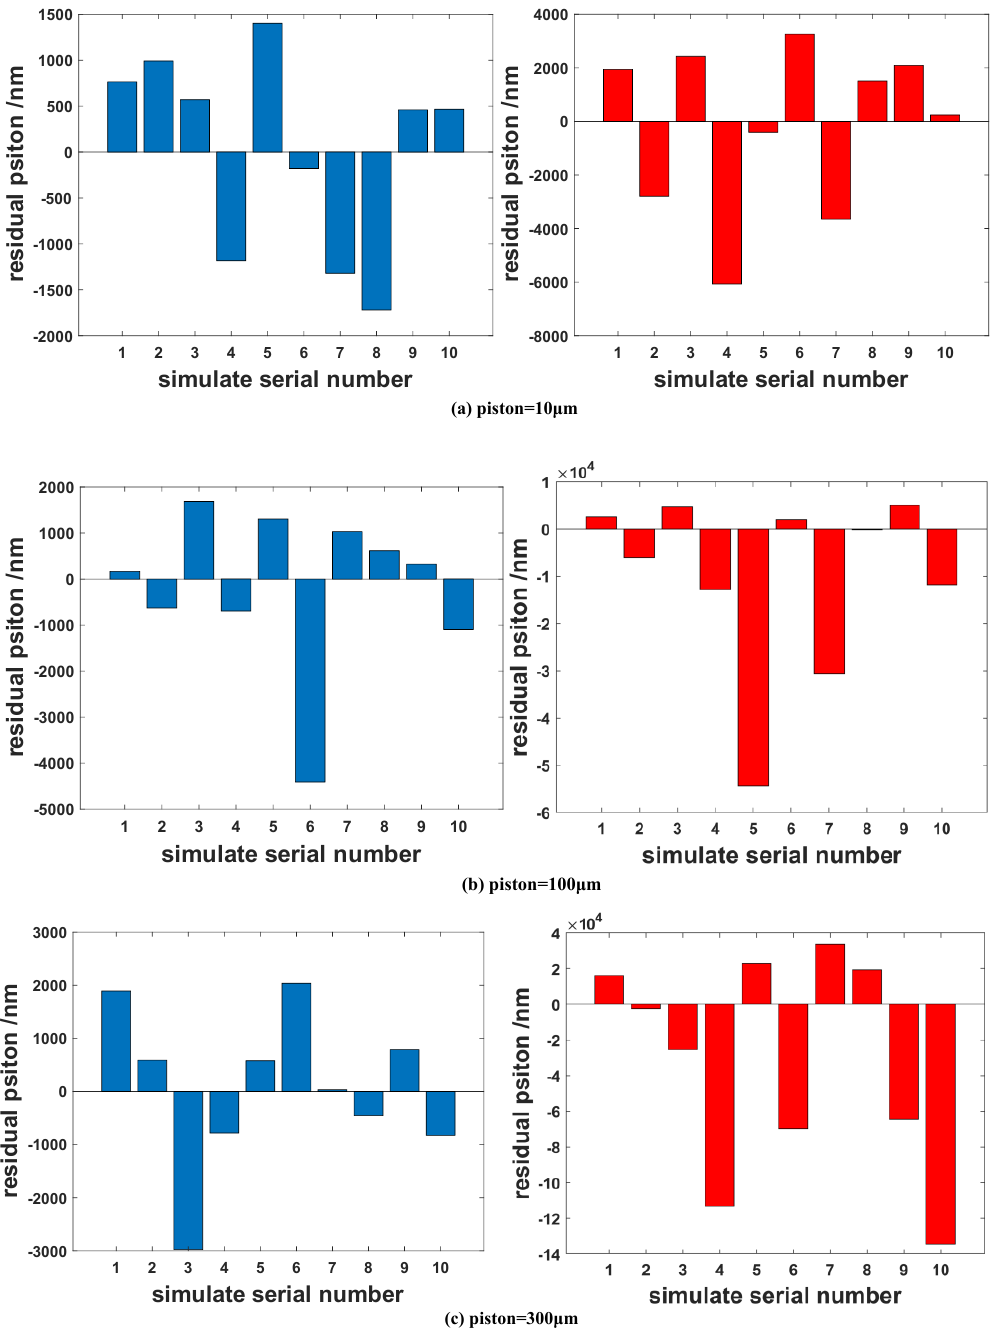
Figure 4. Comparison of simulation results between MWLF ( left ) and synthetic wavelength method ( right ).